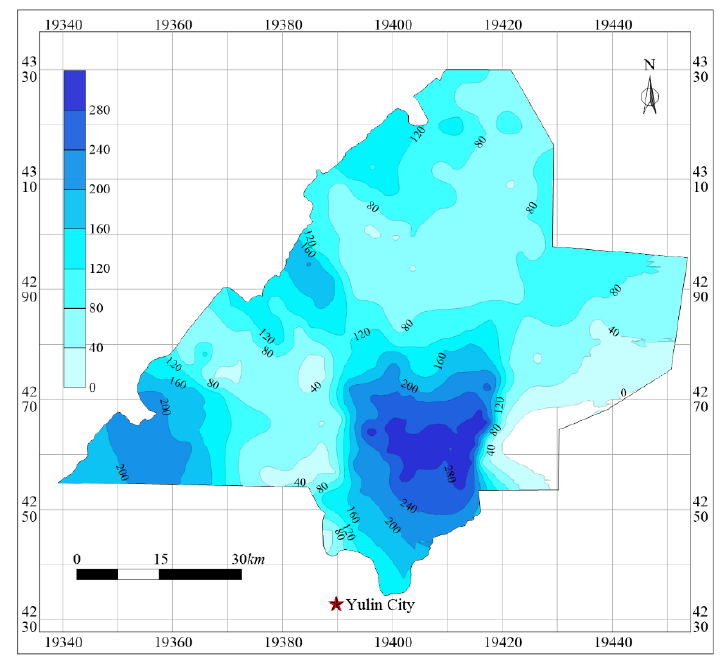
Figure 14. WCFZ height contour (Xi’an geodetic coordinate system 1980; in km).